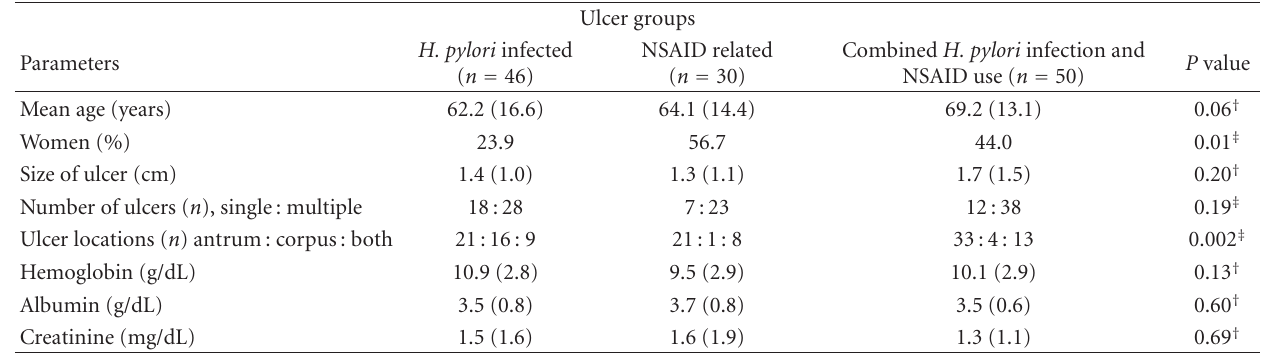
Table 1: Demographic and clinical characteristics of the three gastric ulcer